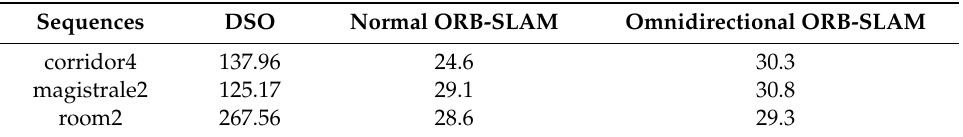
Table 2. Mean Timing Results (ms).